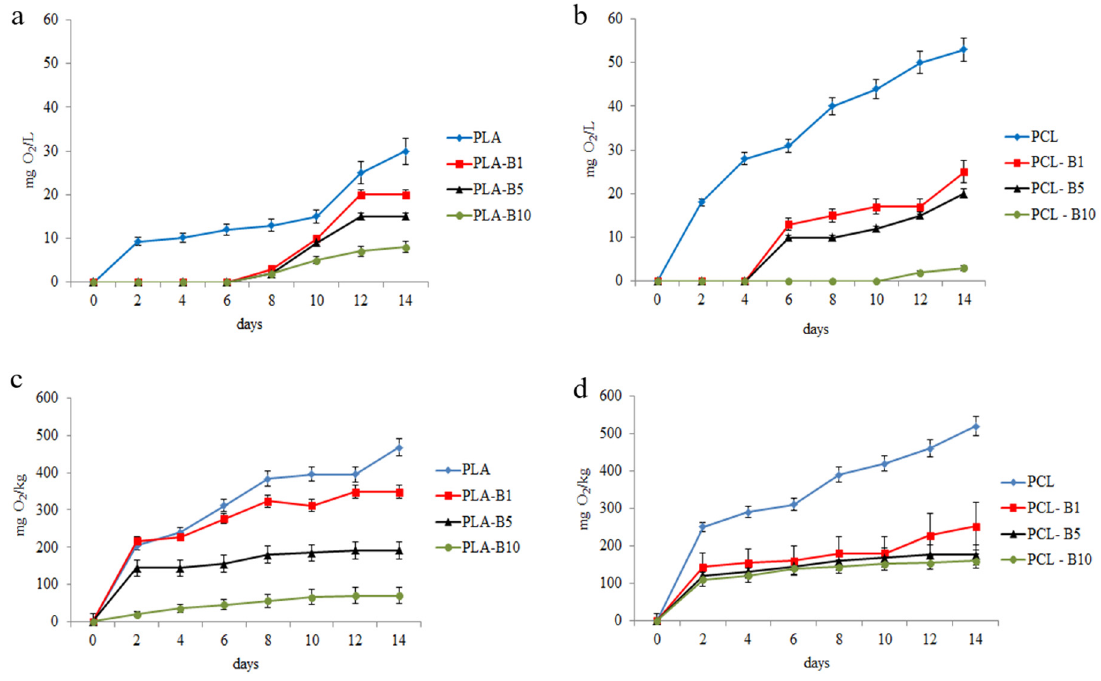
Figure 4. Biological oxygen demand (BOD7) in river water ( a , b ) and soil ( c , d ) in the presence of polymers; values are expressed as mean ± SD ( n =